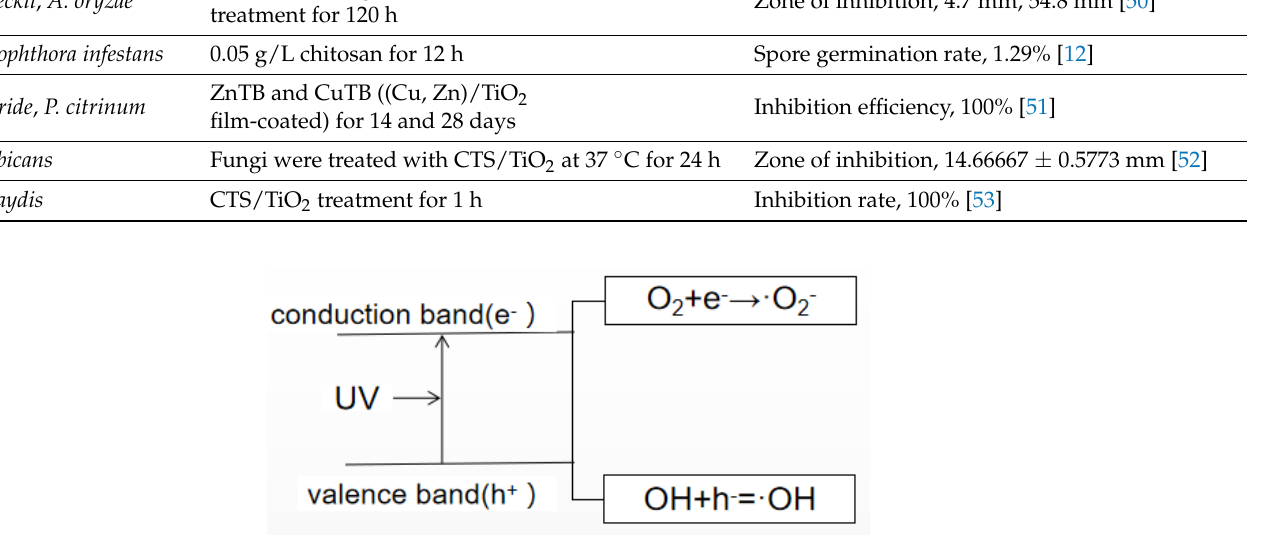
Figure 3. Photocatalytic principle of TiO 2 nanoparticles.